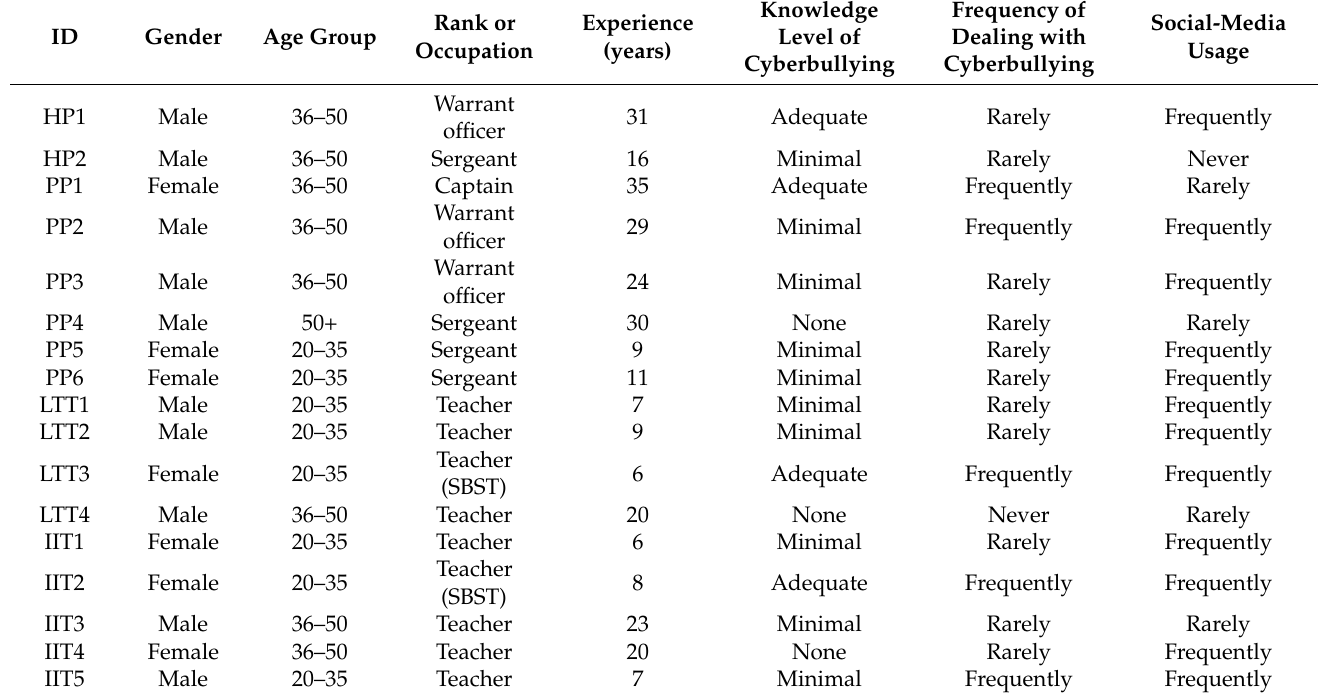
Table 2. Police and teachers’